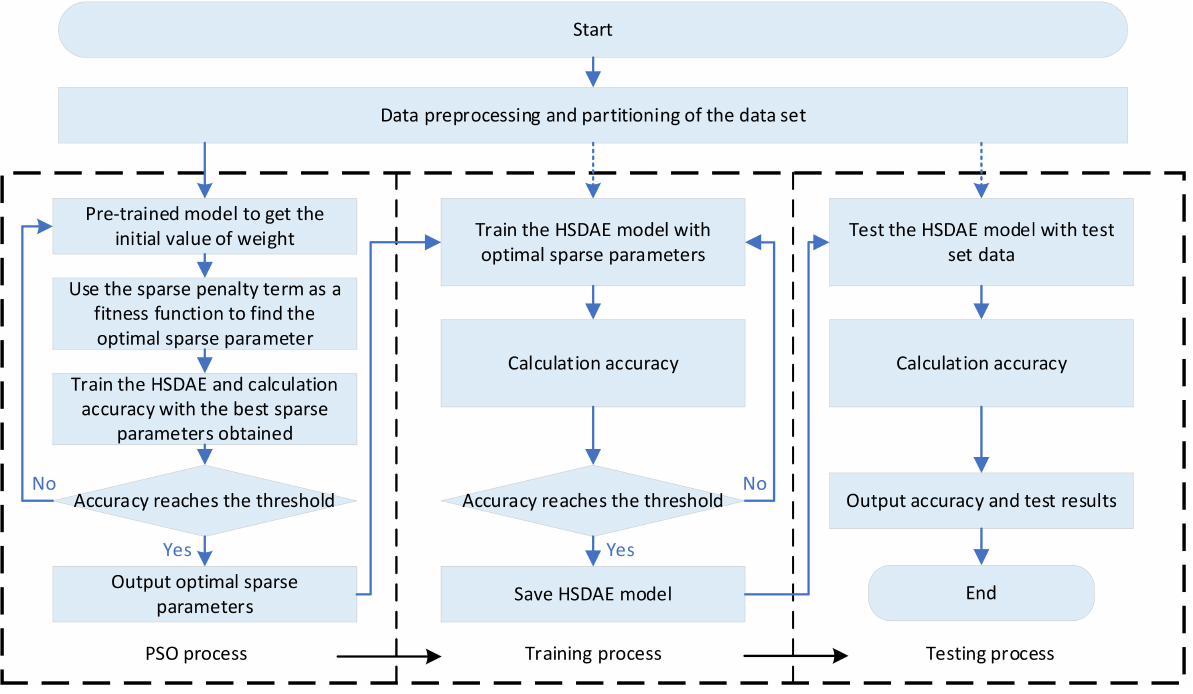
Figure 6. The detailed flow chart of the proposed